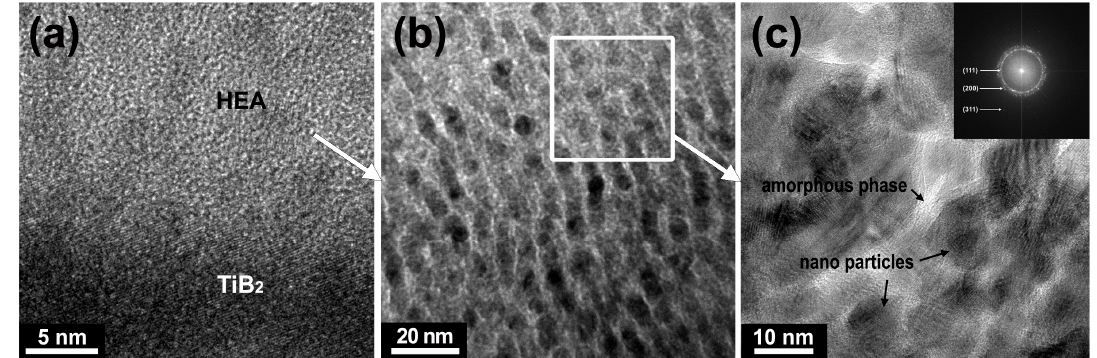
Figure 7. ( a ) HRTEM images of the interface between TiB 2 and HEA for the TiB 2 -5 wt. % CoCrFeNiAl HEA composites sintered at 1650 °C; ( b ) Supra-nano-dual-phase structure in the liquid phase and ( c ) HRTEM image of the nanostructured CoCrFeNiAl HEA within amorphous shells. Inset, a fast Fourier transform image of HEA liquid phase.